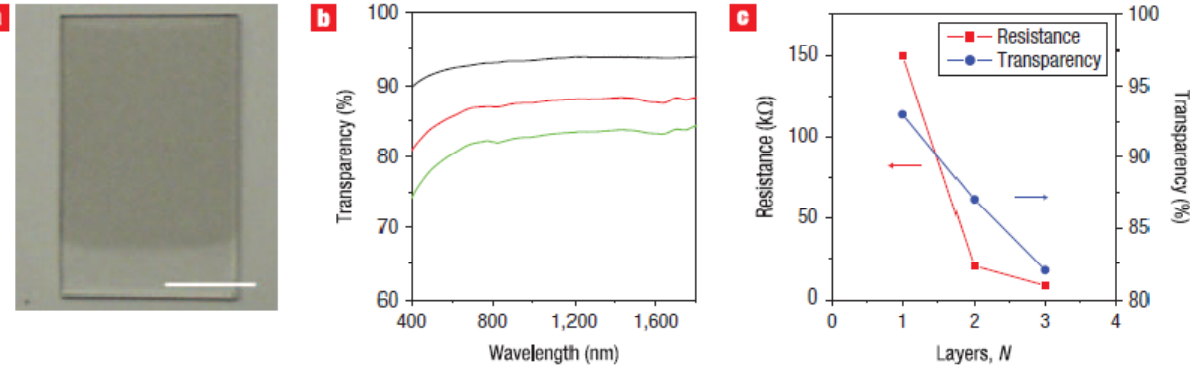
Figure 5. Langmuir-Blodgett (LB) films of graphene sheet. ( a ) A photograph of a film of graphene sheet deposited on the top portion of a quartz substrate. The scale bar is 10 mm; ( b ) Transmission spectra of the single layer (black curve), double layer (red curve) and triple layer (green curve) LB films; ( c ) Sheet resistance (red curve) and transparency at a wavelength of 1000 nm (blue curve) of the LB films with different number of